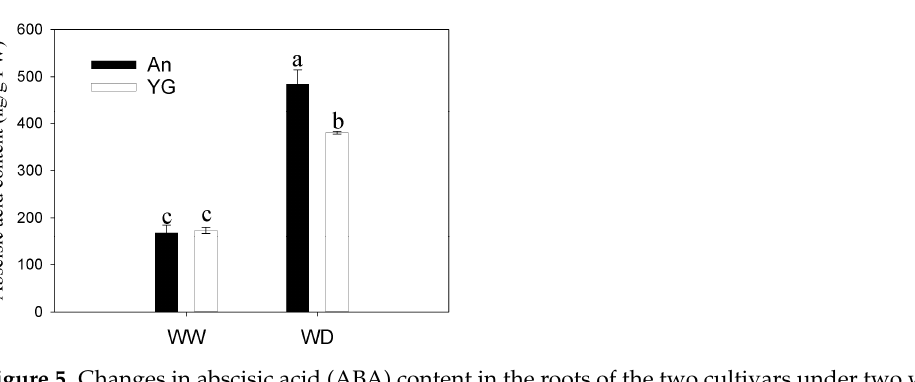
Figure 5. Changes in abscisic acid (ABA) content in the roots of the two cultivars under two water conditions. The different letters represent significant differences of WD, WW, An and YG ( p < 0.05).